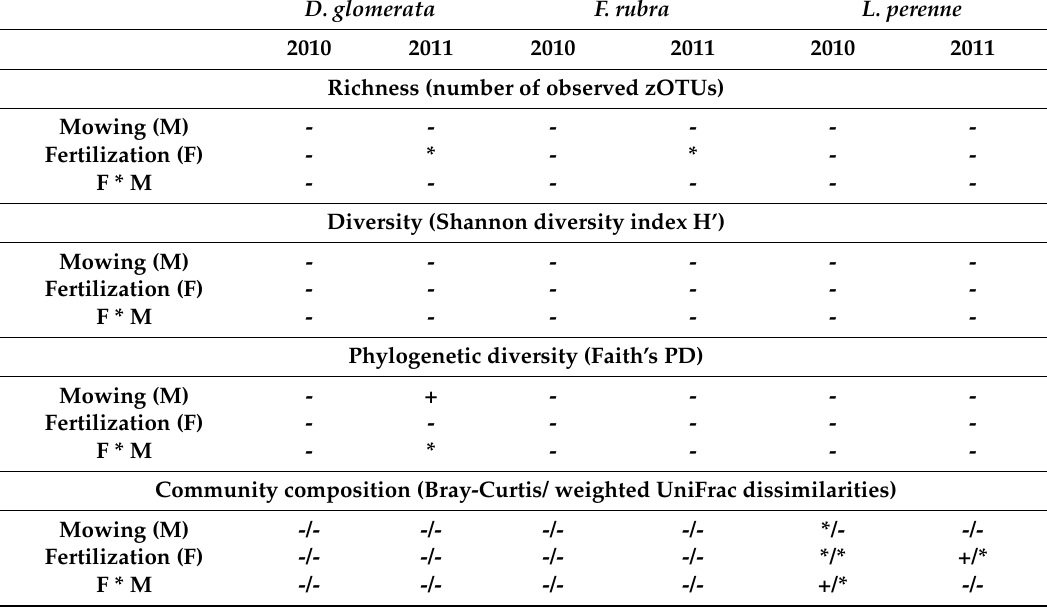
Table 4. Summary of findings. Effect of mowing frequency and fertilizer application on